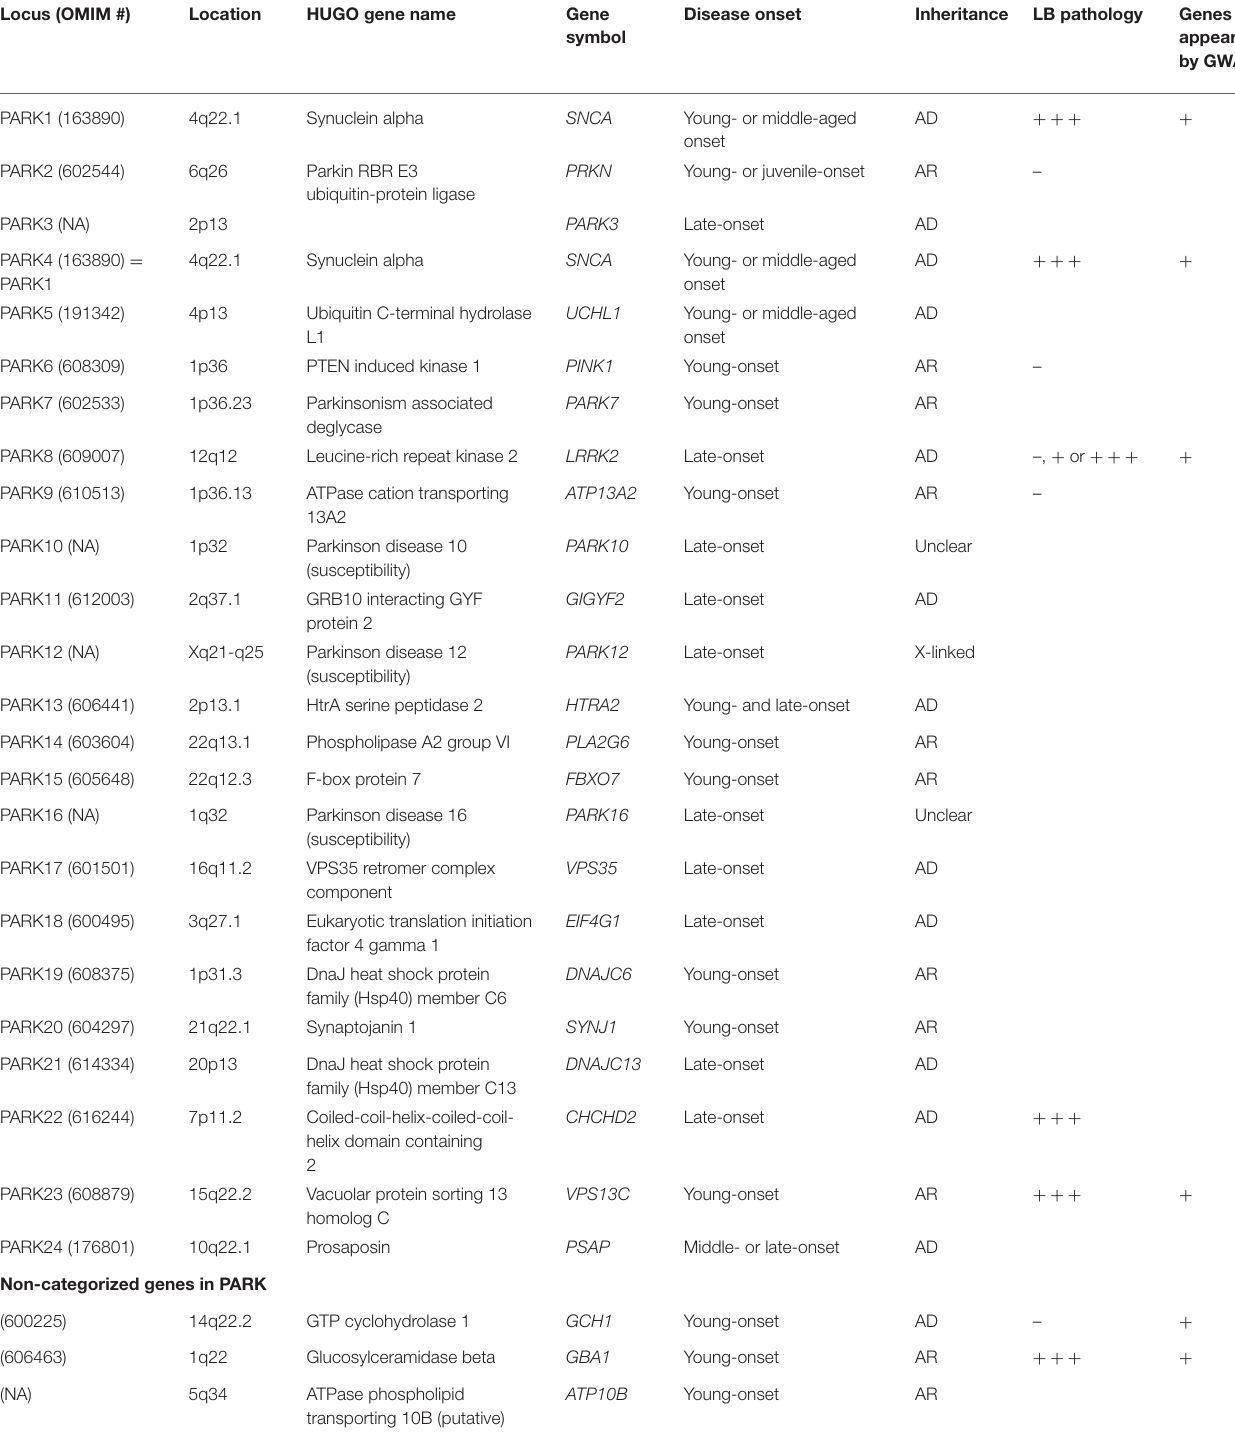
TABLE 1 | PARK categories from the genes related to PD. Locus (OMIM